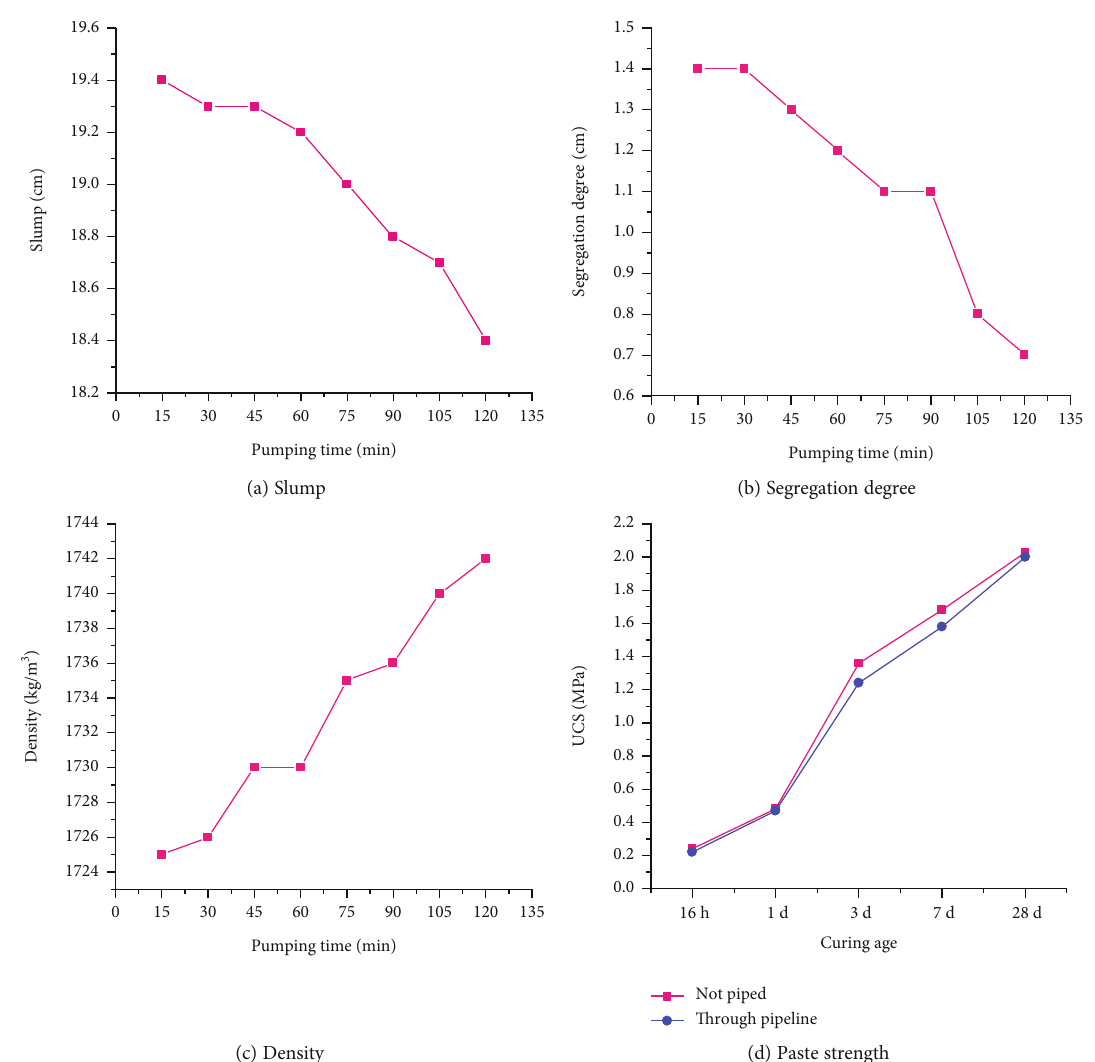
Figure 12: The law of in fl uence of pipeline transportation on paste